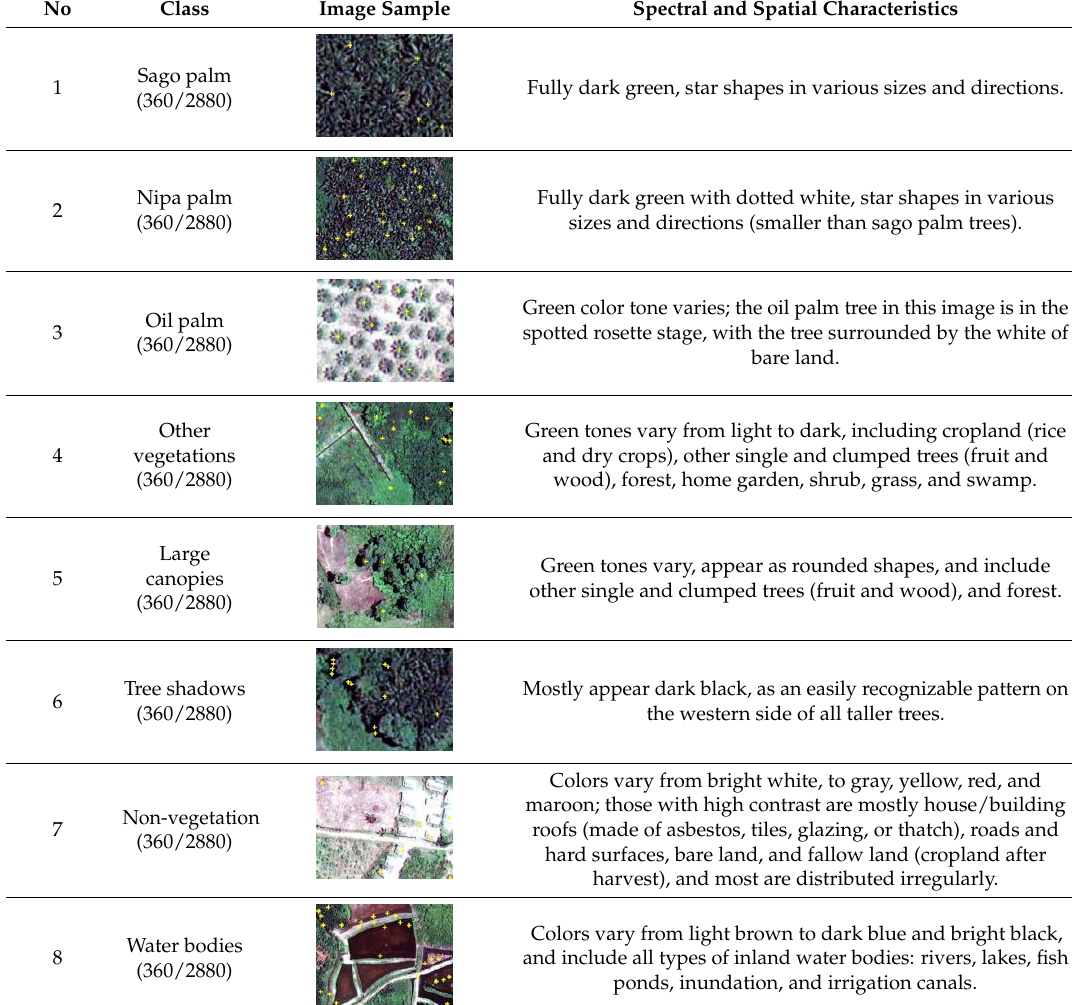
Table 1. Typical characteristics of the LULC class identified from field testing and recognized in Pleiades-1A imagery.